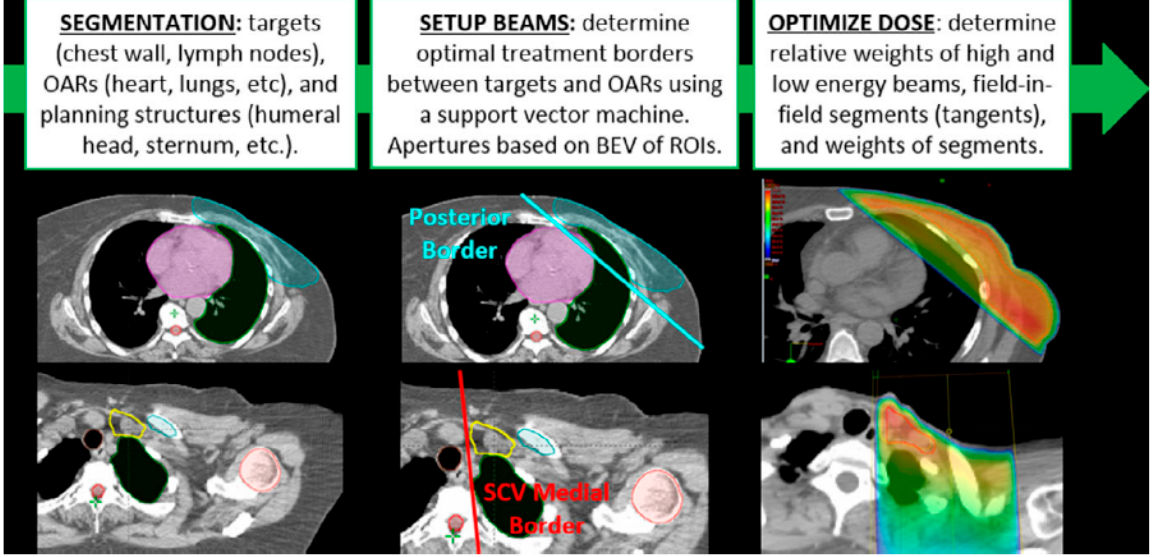
Figure 1. A typical automation workflow starts with automated segmentation of targets and organs at risk (OARs), followed by treatment planning (here described by beam setup and dose optimiza- tion). The individual tasks may be automated separately or a complete end-to-end process with no user intervention until the end. This example is from Kisling et al.